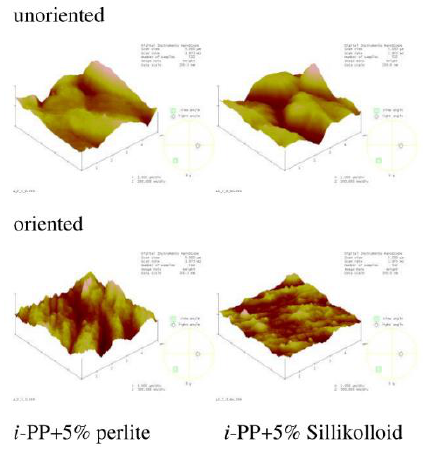
Figure 6. Atomic force microscopy (AFM) images of the unoriented ( top ) and oriented ( bottom ) neat i -PP film and i -PP films with different content of glass beads (GB). Scan area: 5 μm × 5 μm, z-scale for the unoriented films: 200 nm, for the oriented films: 300 nm.